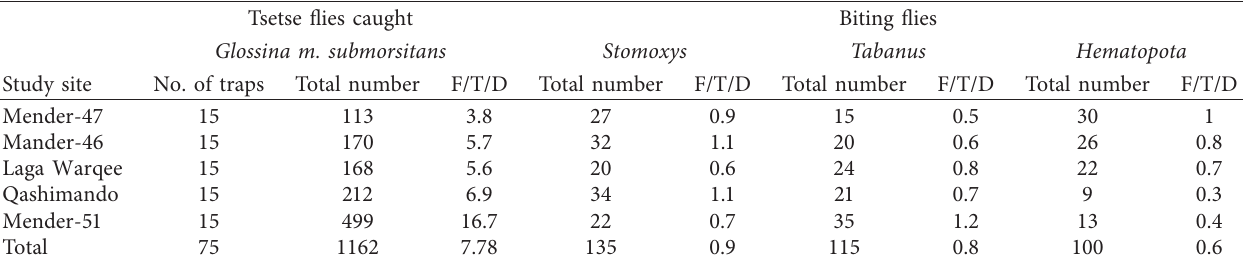
Table 2: Fly caught number and their apparent density in different selected areas of the district.